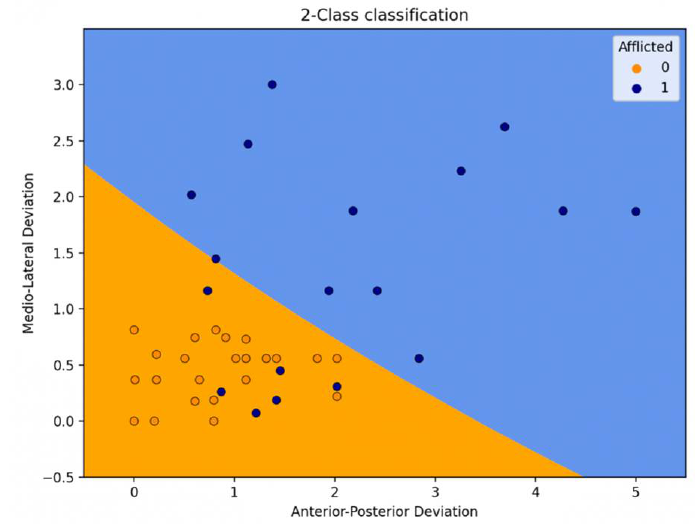
Figure 6. Prediction as seen on a graph.